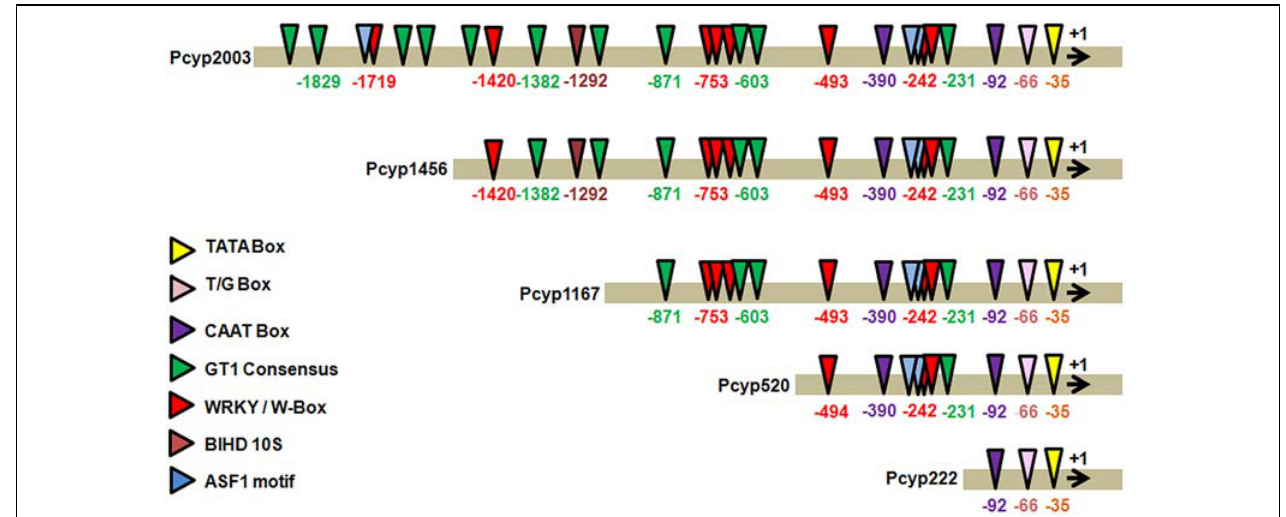
FIGURE 2 | In silico analysis of cis- regulatory elements in candidate gene promoter CYP76M7 (LOC_Os02g36110) and its four deletion fragments using PLACE online tool; Pcyp2004 ( CYP76M7 promoter-2004 bp), Pcyp1465 ( CYP76M7 promoter-1456 bp), Pcyp1167 ( CYP76M7 promoter-1167 bp),